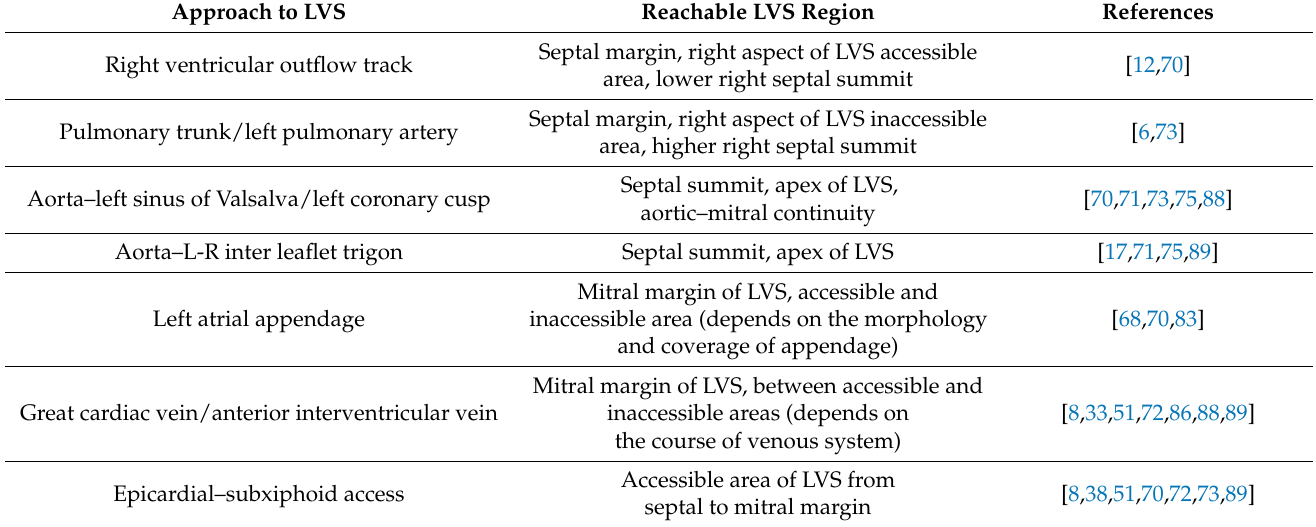
Table 1. List of approaches to the LVS and possible ablation coverage in the individual regions.